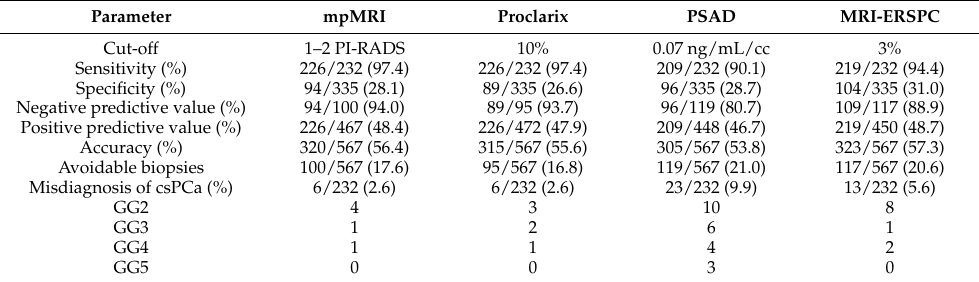
Table 2. Overall performance of mpMRI, Proclarix, PSAD, and MRI-ERSPC model for csPCa detection.